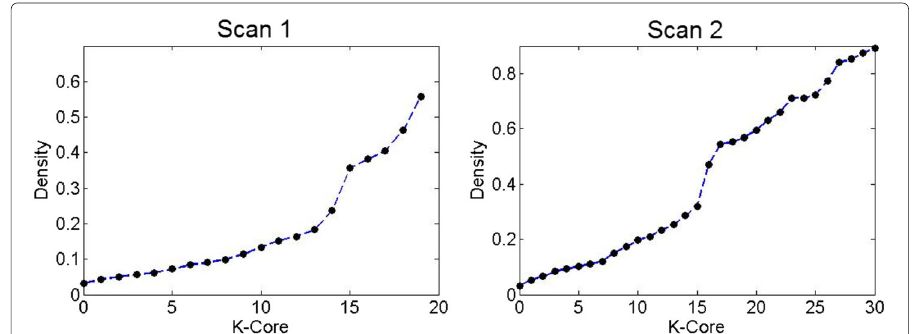
Fig. 5 Network density as a function of the k th core for scan-1 (left panel) and scan-2 (right panel)